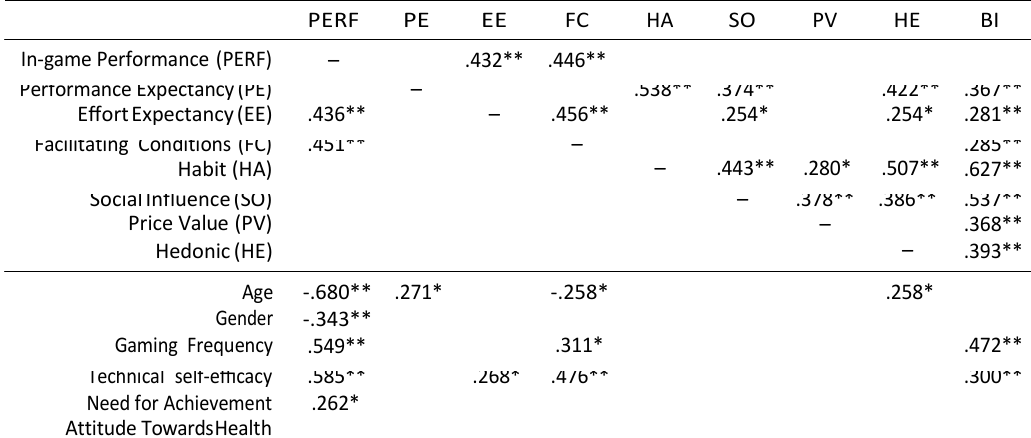
Table 4. Relationships between independent and explanatory variables and the UTAUT2 dimensions ( n = 64